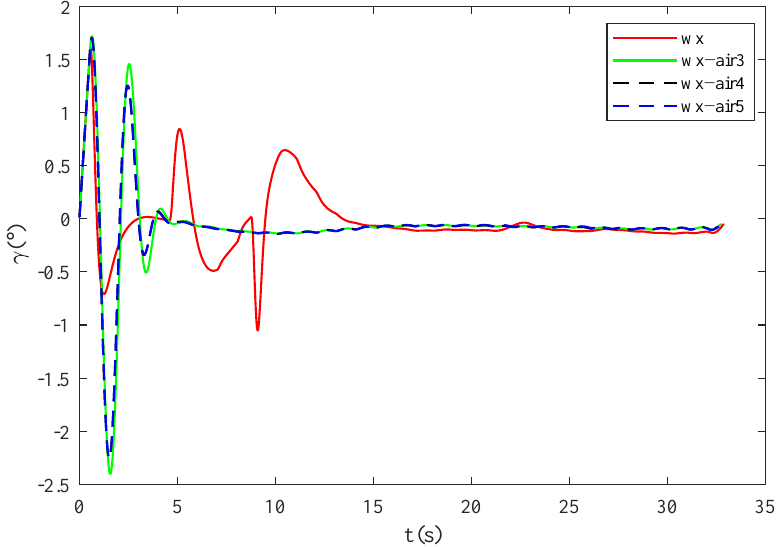
Figure 4. Roll angle response curve under steerage deviation.